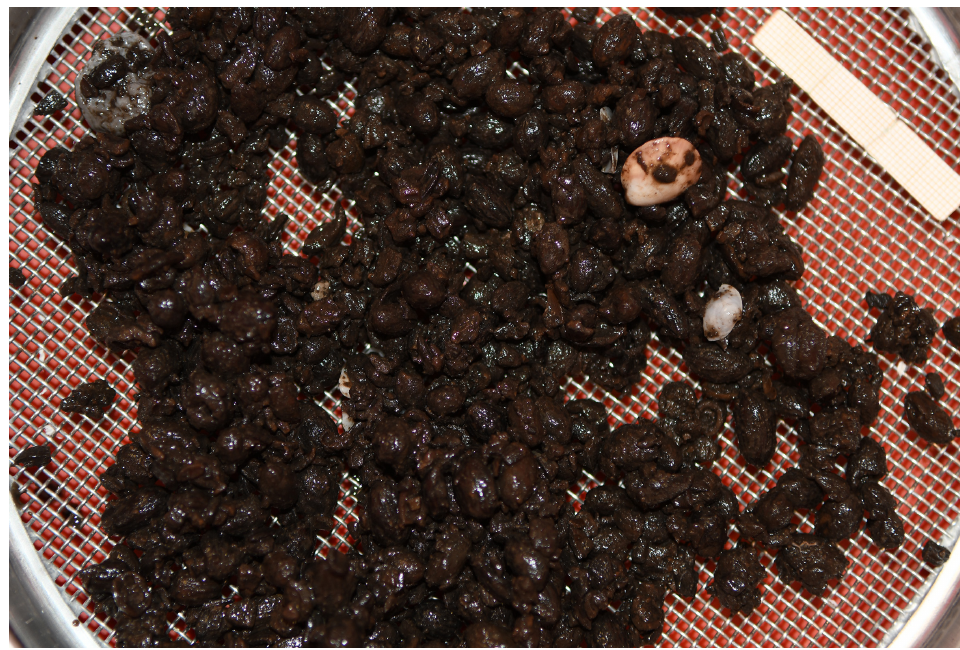
Figure 2. Olive stones from Hishuley Carmel site during cleaning, sorting and recovery (photo taken by Sarah Ivorra).